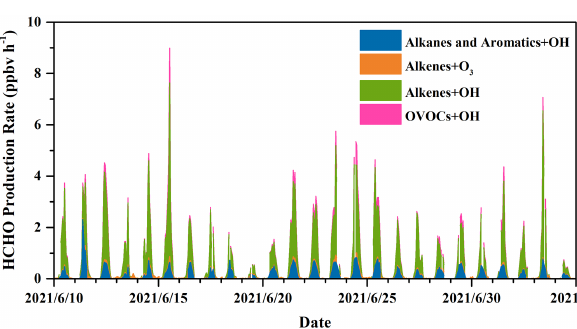
Figure 5. Time profiles of the calculated HCHO production rates during the